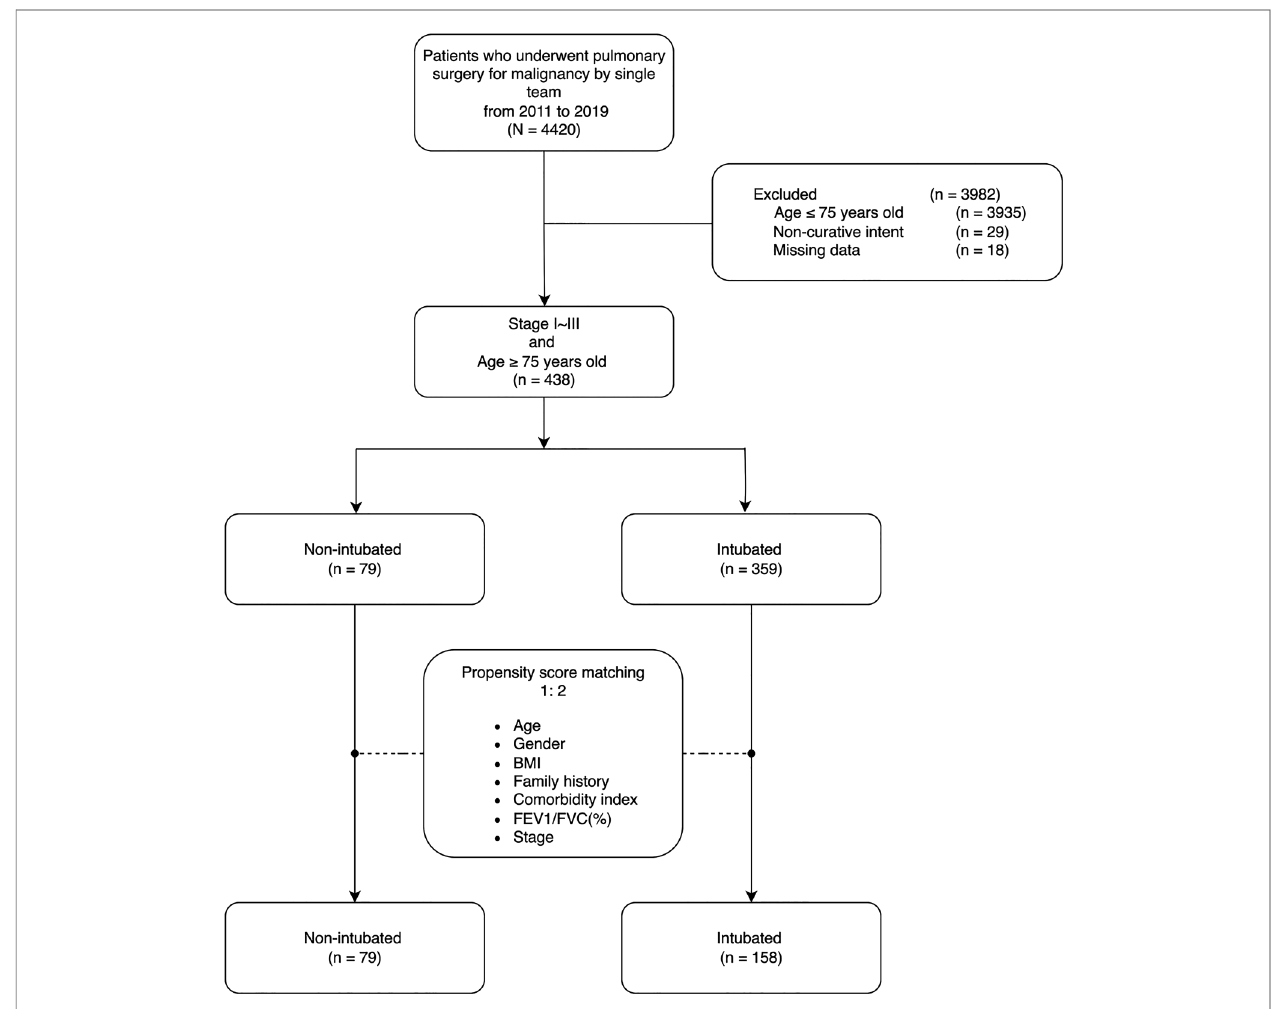
FIGURE 1 | Algorithm for patient selection. Abbreviations: BMI, body mass index; FEV1/FVC, forced expiratory volume in 1 s/forced vital capacity